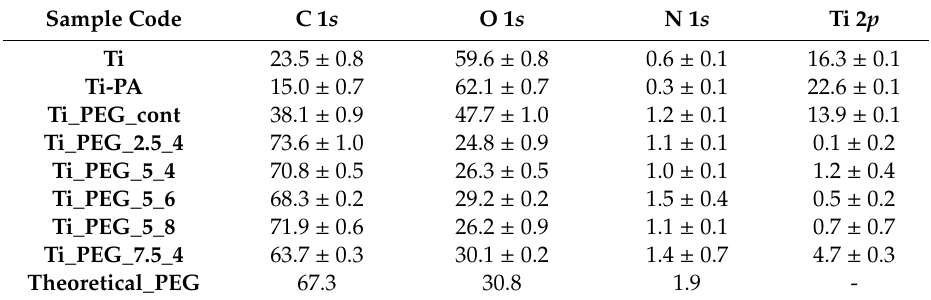
Figure 2. FTIR Nicolet 6700 equipment in the Attenuated Total Reflectance mode (ATR-FTIR) of Ti_PEG_5_6 ( a ), components contribution (as atomic %) to the C 1 s peak for the X-ray photoelectron spectroscopy (XPS) decomposition ( b ). Table 2. Atomic % of the main components found on the titanium samples before and after electrodeposition, as measured by XPS.